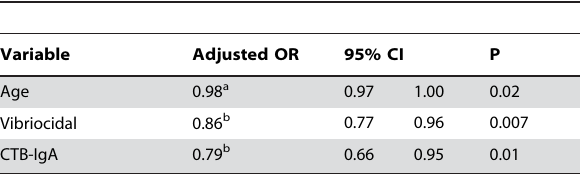
Table 3. A multivariate logistic regression model of predictors of protection from infection with V. cholerae O1 El Tor in household contacts